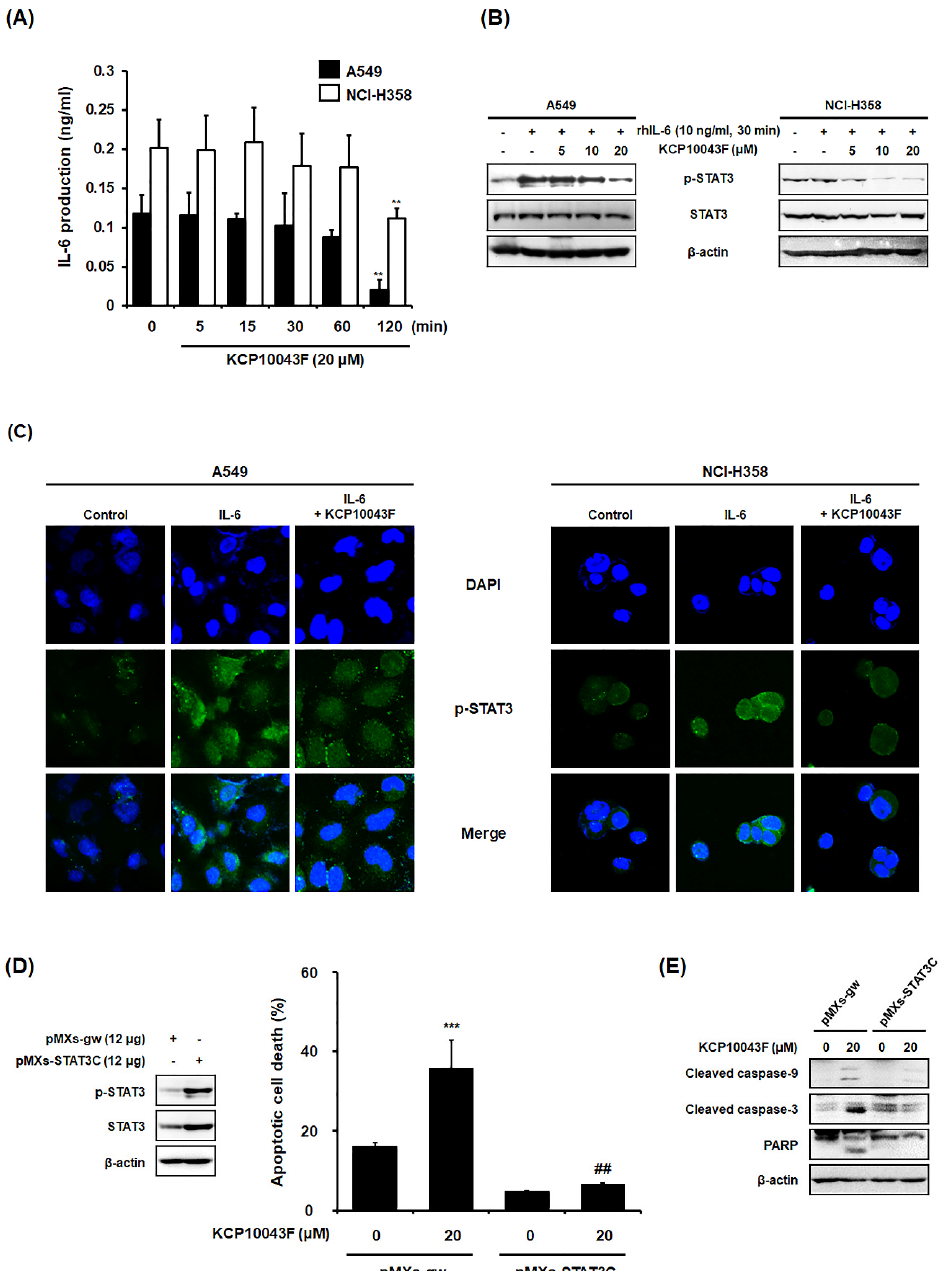
Figure 5. E ff ect of KCP10043F on the IL-6-induced STAT3 signaling pathway in A549 and NCI-H358 cells. ( A ) A549 and NCI-H358 cells were treated with 20 µ M KCP10043F for the indicated times (5, 15, 30, 60, or 120 min). IL-6 production in the cell culture media was quantified using an EIA kit. Data represent the mean ± S.D. of the results from three independent experiments. ** p < 0.01 vs. untreated control group. After pretreatment with KCP10043F (5, 10, or 20 µ M) for 1 h, the cells were stimulated with recombinant human IL-6 (10 ng / mL) for 30 min, and STAT3 activation was determined by ( B ) Western blot and ( C ) immunofluorescence analyses. Cells were transfected with pMXs-gw and pMXs-STAT3C for the overexpression of STAT3. ( D ) Transfected A549 cells were treated with 20 µ M KCP10043F for 12 h and analyzed by flow cytometry with annexin V-FITC and PI staining. Data represent the mean ± SD. of the results from three independent experiments. *** p < 0.001 vs. pMXs-gw-transfected control group. ## p < 0.001 vs. KCP10043F-treated control group. ( E ) Western blot analyses were performed to detect apoptotic cell